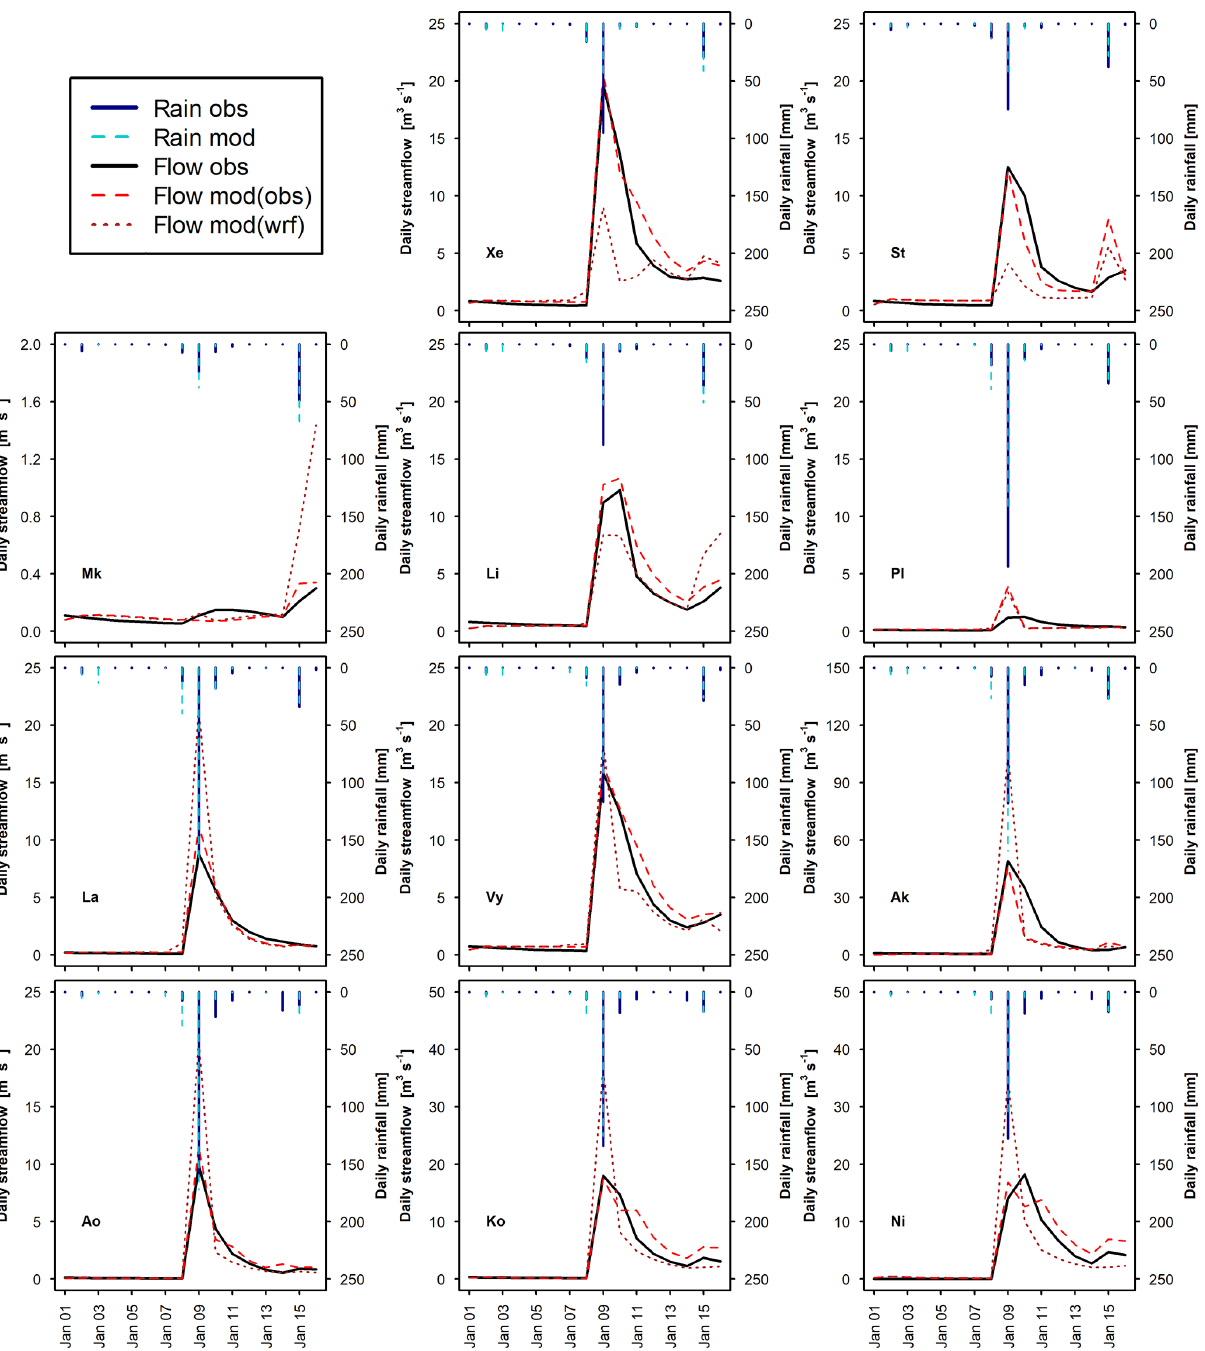
Figure 6. Observed daily hydrographs (Flow obs) and hydrographs obtained with the calibrated WRF-Hydro model (Flow mod) forced with observed rainfall (Rain obs) and with WRF-modelled rainfall (Rain wrf) for the January 1989 calibration event, for 11 representative watersheds (see Table 1 for watershed